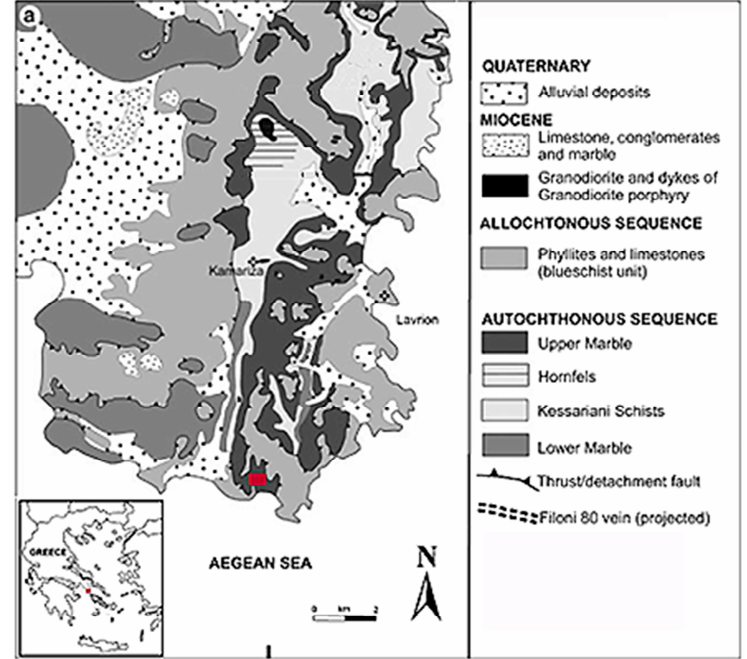
Figure 1. Simplified geological map of the Lavrion ore district (modified after [1,6,22]), showing the location of the studied Fe-Mn-mineralization (red rectangle).